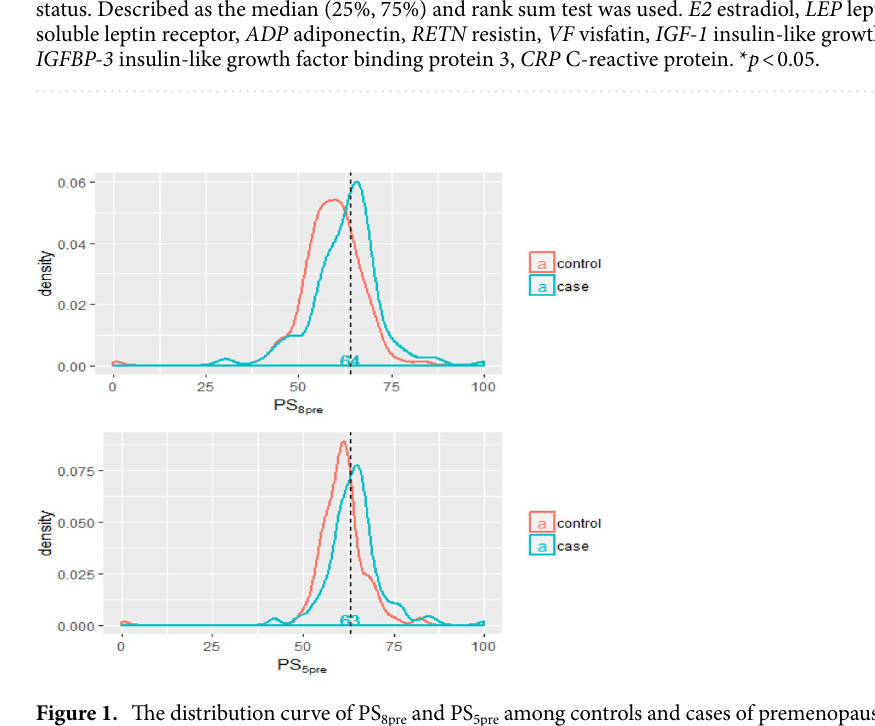
Figure 1. The distribution curve of PS 8pre and PS 5pre among controls and cases of premenopausal women (the dashed line was the cut-off value based on ROC). The curve was conducted using R 3.5.1 software (R Core Team, Vienna, Austria, 2018. https:// www.R- proje ct. org/) and Microsoft EXCEL software (Microsoft, USA, 2016. https:// www. micro soft. com/ zh- cn/ micro soft- 365/